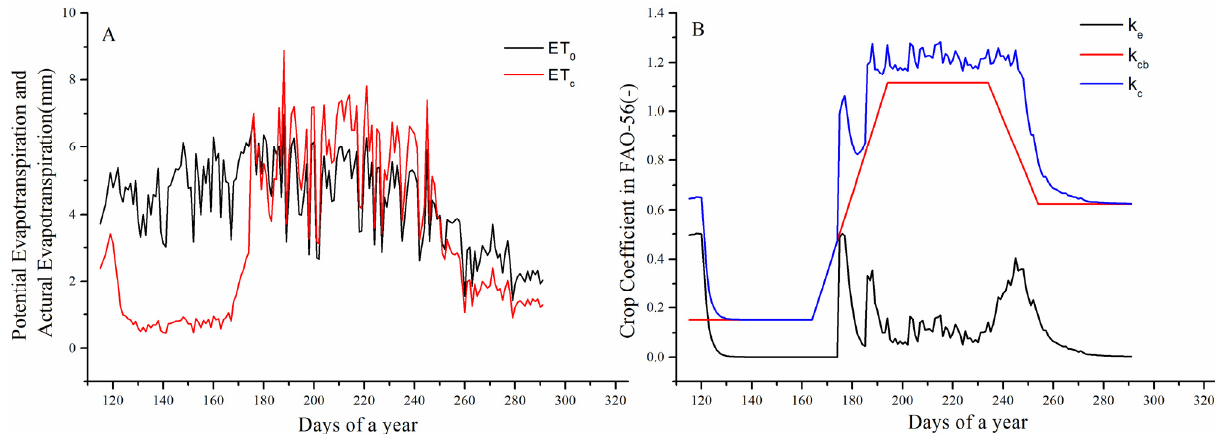
Figure 3. ( A ) Reference evapotranspiration ( ET 0 ) and cotton potential evapotranspiration ( ET c ); ( B ) Crop coefficient ( K c ), basal coefficient ( K cb ), and evaporation coefficient ( K e ) of the FAO-56 dual crop coefficient